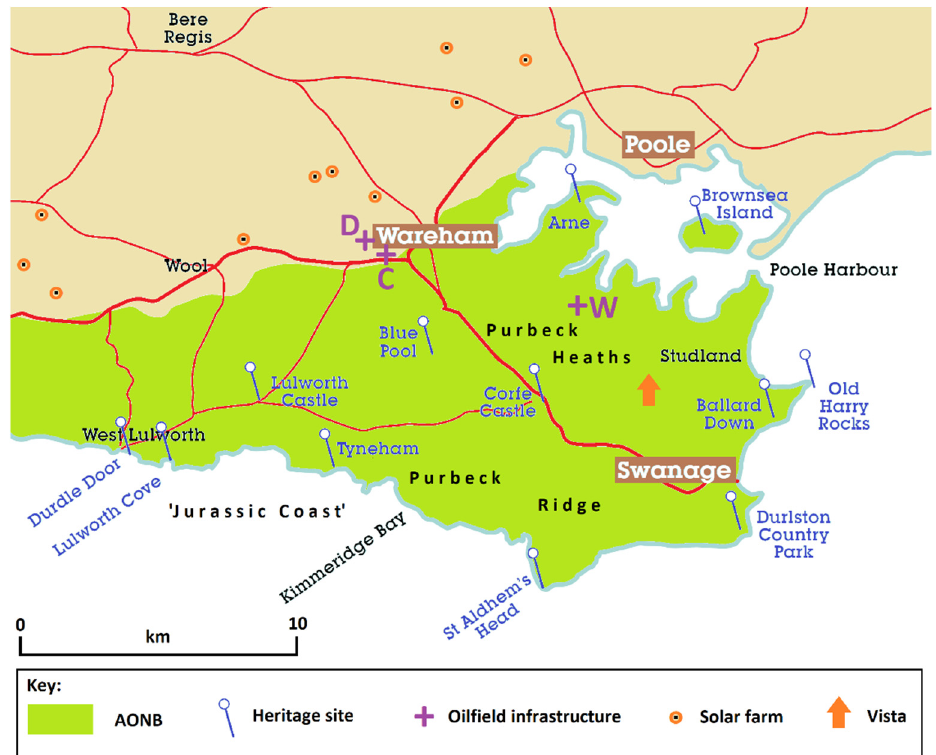
Figure 6. More detailed map, adapted after [54], showing the locations of the Wytch Farm gathering station (W) and the Wareham WC and WD sites (C and D). Also shown is the designated area of the Dorset Area of Outstanding Natural Beauty (AONB), some of its principal geological, biological, and historical heritage sites, and the locations (from Ordnance Survey topographic maps; [55] provides additional details) of solar farms in the vicinity. Well pads, connected by pipelines to the Wytch Farm gathering station (not shown; [56] provides details), are located in the northern part of the Purbeck Heaths from Arne eastward, as well as on the small Furzey Island to the SW of Brownsea Island. ‘Vista’ denotes the viewpoint for Figure 12.